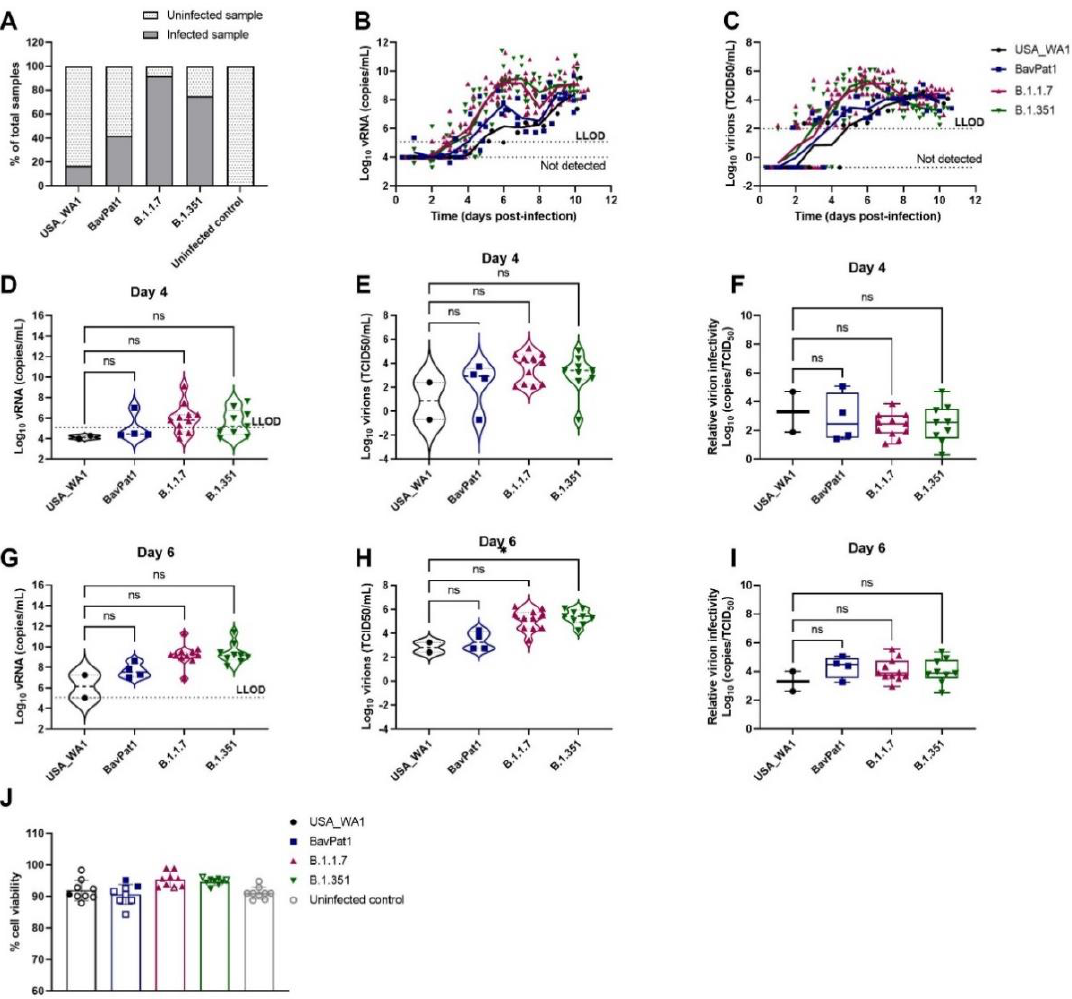
Figure 1. SARS-CoV-2 VoC replication kinetics in human small airway epithelial cell cultures. Viral replication of SARS-CoV-2 VoC at the viral input of 2 × 10 3 TCID 50 /insert in HsAEC cultures. The cultures were incubated at 35 °C and maintained for 10 days. ( A ) Percentages of infected cultures in total tested samples. Two independent experiments with HsAEC from two different donors were performed. Six independent inserts were used for each condition per experiment. ( B , D , G ) Viral RNA or ( C , E , H ) infectious particles in apical washes of infected cultures were determined by RT- qPCR or by end-point titration assay, respectively. ( F , I ) Relative virion infectivity (i.e., the ratio of the number infectious particles over the number of viral RNA). ( J ) Cell viability of HsAEC cultures. Infected samples were represented as closed markers whereas non-infected samples were indicated as open markerss. Dots represent individual samples. The dotted lines indicate the lower limit of detection (LLOD). ns p > 0.05, * p < 0.05. Likewise, a similar observation was made using HAEC of bronchial origin (HbAEC) (Figure 2). Whereas six out of six samples were infected by either the B.1.1.7 or the B.1.351 variant, only 50% of the cultures could be infected with either USA-WA-1 or BavPat1 iso- lates ( n = 6) (Figure 2A). At 2 d.p.i., the viral RNA loads were determined at 2 × 10 5 , 7 × 10 5 , 1 × 10 8 , and 2 × 10 6 RNA copies/mL (Figure 2D) and the infectious virus titers were 5 × 10 4 , 1 × 10 5 , 5 × 10 6 , and 3 × 10 5 TCID 50 /mL (Figure 2E) in USA-WA1, BavPat1, B.1.1.7, and B.1.351 groups, respectively. As a result, no disparity in the virion infectivity was ob- served ( p = 0.1169; Figure 2F). Of note, the alpha-infected cultures produced a lower infec- tivity ratio in comparison to the ancestral strain USA-WA1 on day 4 p.i. ( p = 0.0162; Figure 2I). Cultures incubated with any isolate maintained at least 90% cell viability after the 10- day experiment (Figure 2J).